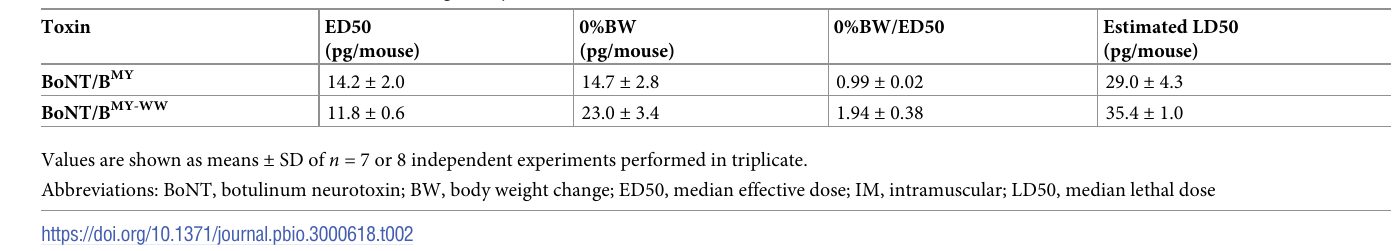
Table 2. Mean ED50, 0%BW, and LD50 following IM injection in